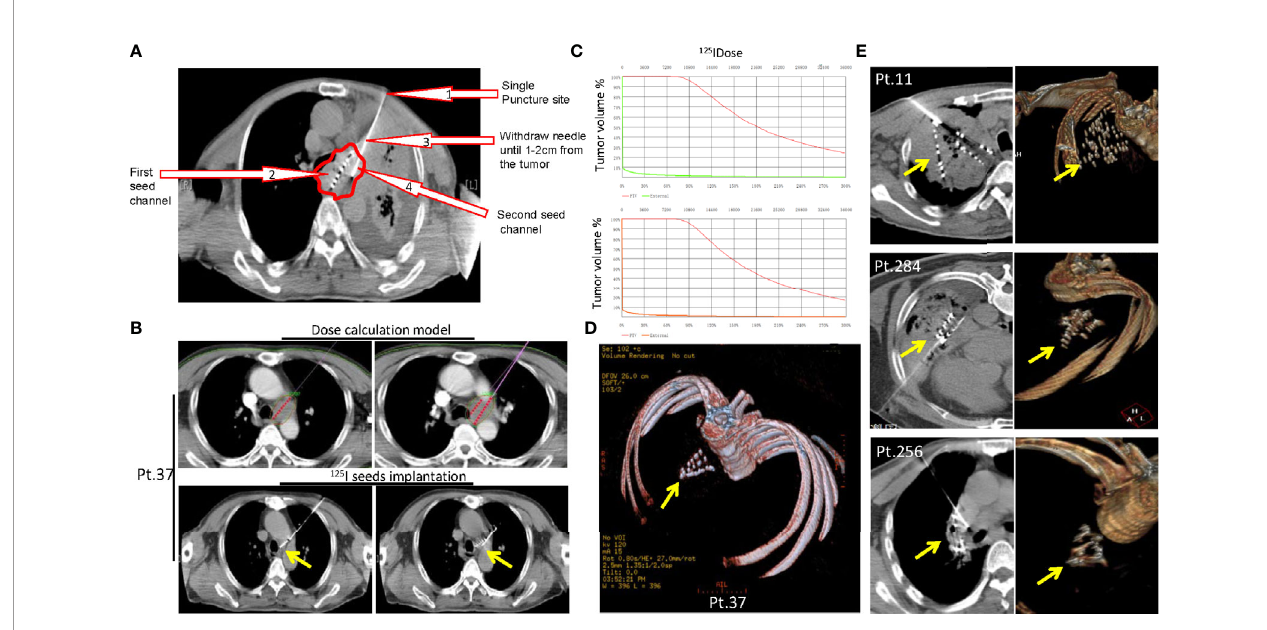
FIGURE 8 | Three-dimensional cone shape was formed using a single needle. (A) An example CT scan showing how to operate two punctures using a single needle. SNCP- 125 I was achieved by selecting one puncture site on the skin (Arrow 1), withdrawing the needle upon completion of 125 I seed implantation in the fi rst needle channel (Arrow 2) until the needle tip was 1-2cm from the tumor (Arrow 3), then adjusting puncture direction and performing the second puncture (Arrow 4) with the needle still inside the thoracic cavity. Red circle-tumor. (B) Representative CT scans of pre-treatment radioactive dose calculation in Patient 37 through treatment planning system (TPS), and post-treatment implanted seeds paths as shown in CT scans. (C) Three seed paths were able to cover 90% of the tumor volume by forming a three-dimensional (3D) tapered path pre-calculated through TPS plan. (D) 3D reconstruction of the implanted seeds in Patient 37 showed formation of a cone shape. (E) Three other representative 3D reconstructed implanted seeds in Patient 11, 284 and 256 undergoing SNCP- 125 I brachytherapy. Yellow